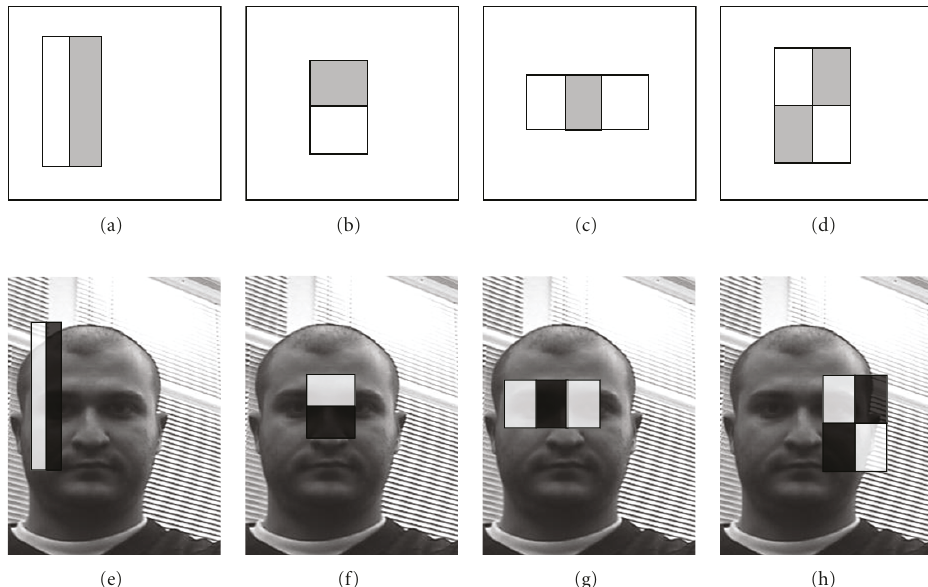
Figure 10: Example rectangle features shown relative to the enclosing detection window. The sum of the pixels that lie within the white rectangles is subtracted from the sum of pixels in the grey rectangles. Two-rectangle features are shown in (a) and (b). (c) shows a three- rectangle feature, and (d) a four-rectangle feature. (e), (f), (g), and (h) show these features overlaid on an acquired face, during the face detection stage. The outputs of several such features are combined to make a final decision as to whether a face is present or not in the frame.